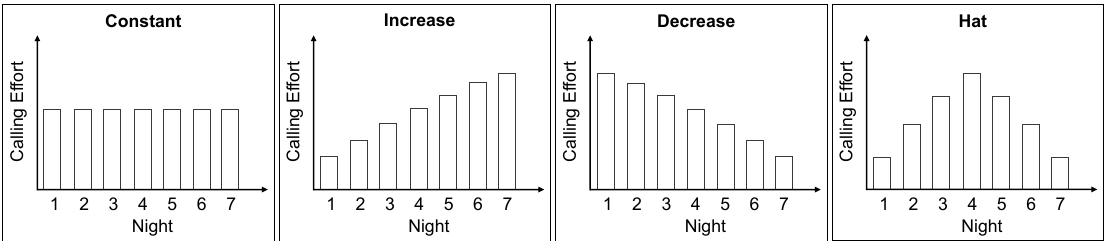
Figure 1. Schematic of four female moth calling strategies, expressed as female calling effort over a typical seven night call. Calling effort is quantified as the time females spent calling males and/or the pheromone